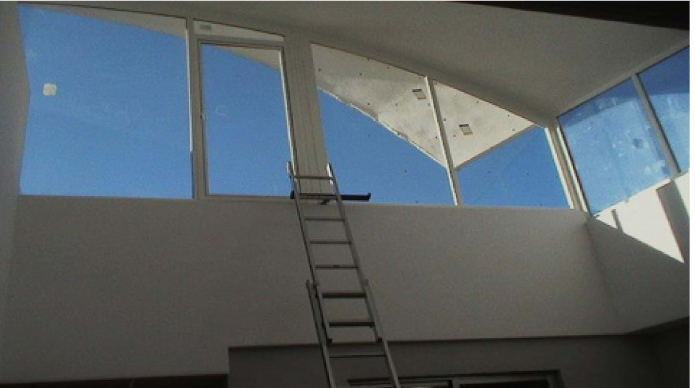
Figure 8. The interior view of the aspect of the residential units with vents for